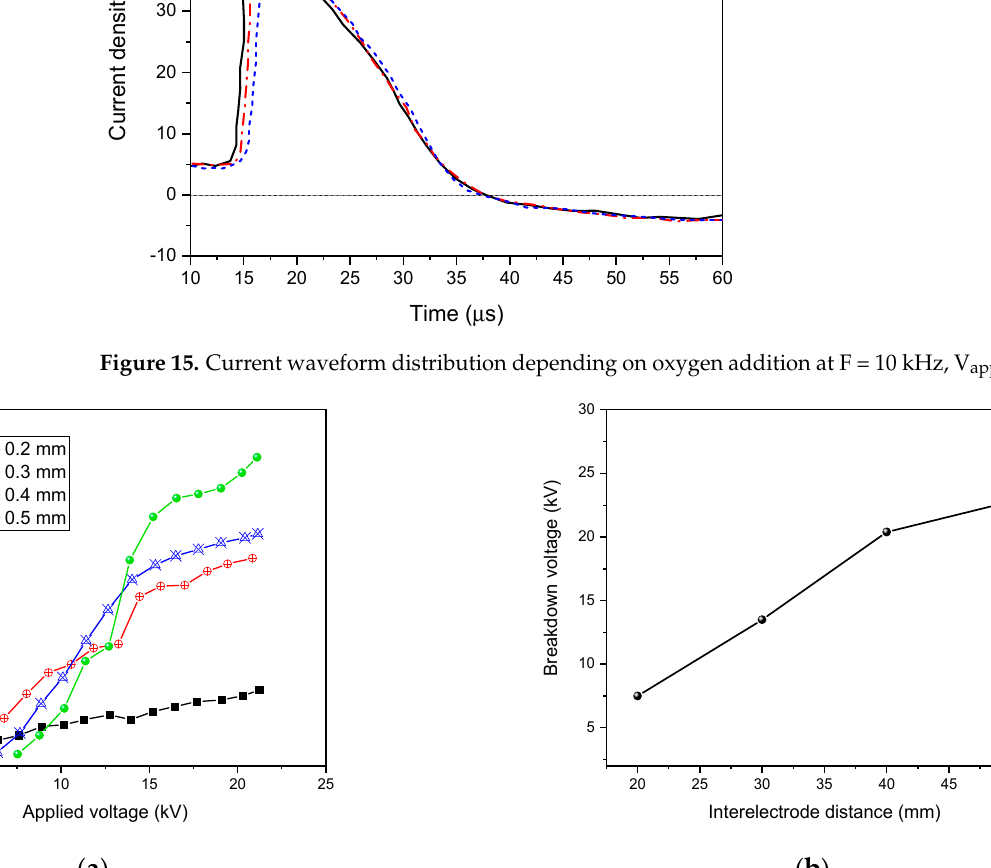
Figure 15. Current waveform distribution depending on oxygen addition at F = 10 kHz, V app = 30 kV.